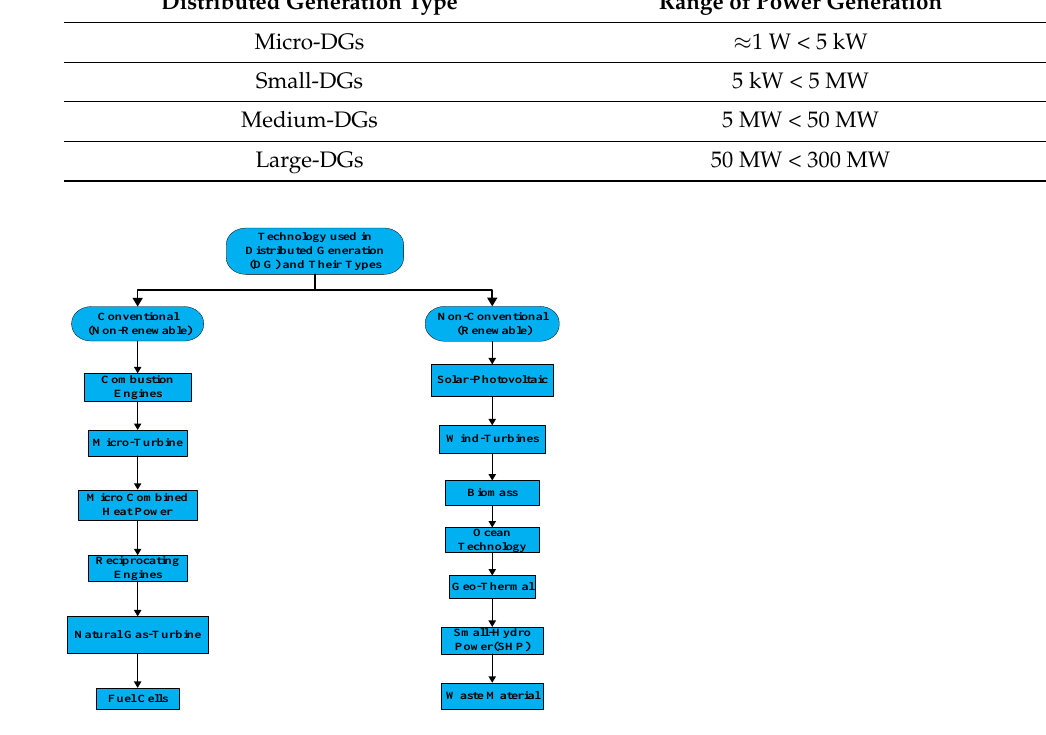
Figure 1. Different types of DG technology. Table 2. Various DG technology with their per module specification and efficiency range.